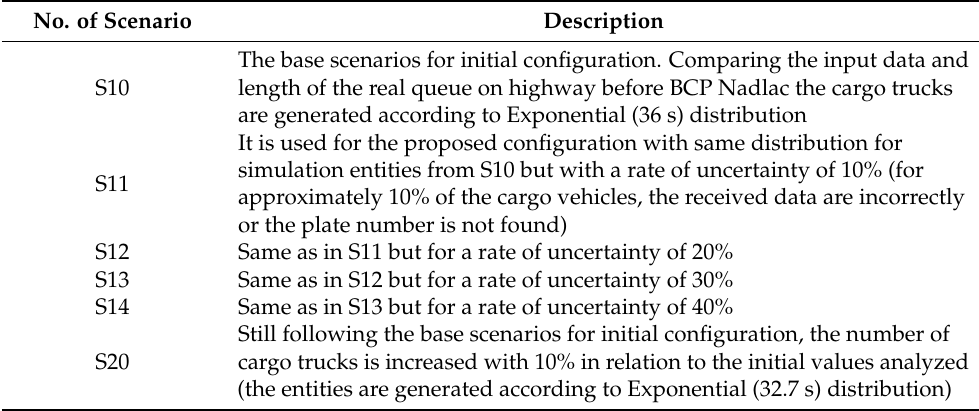
Table 2. The proposed attributes of simulation